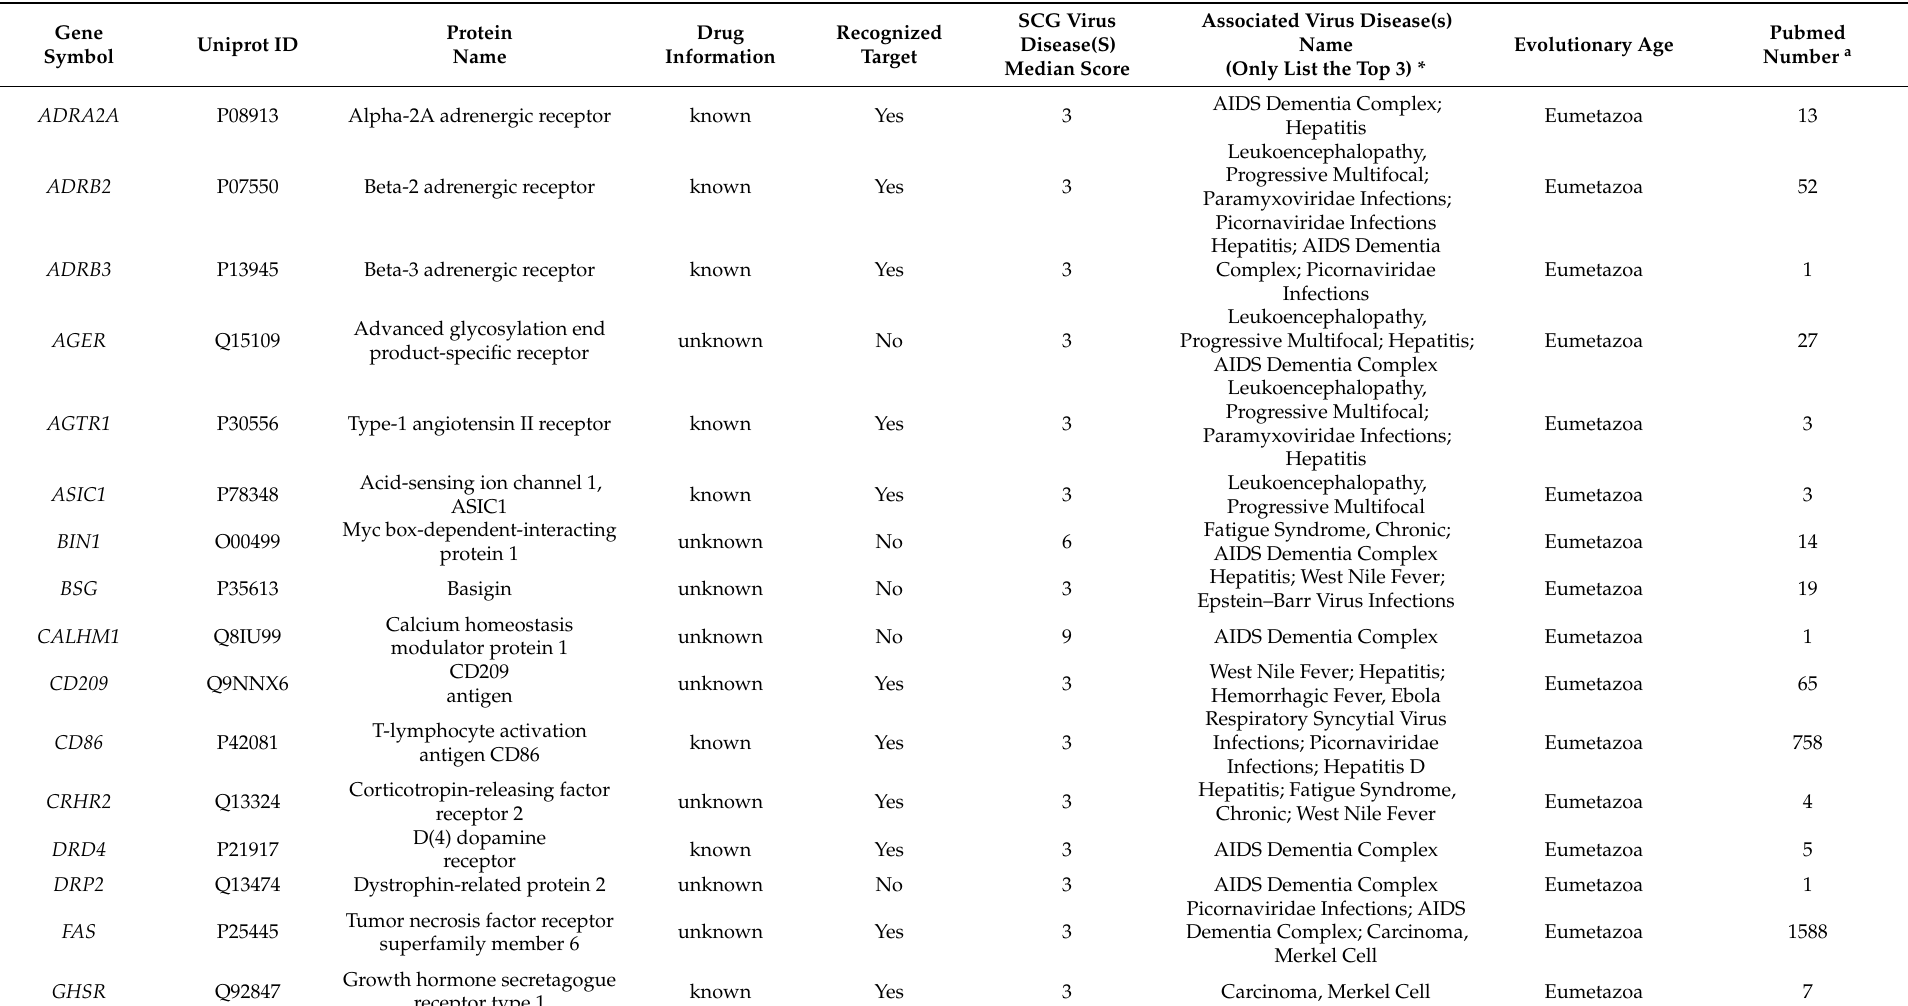
Table 2. Basic information of candidate